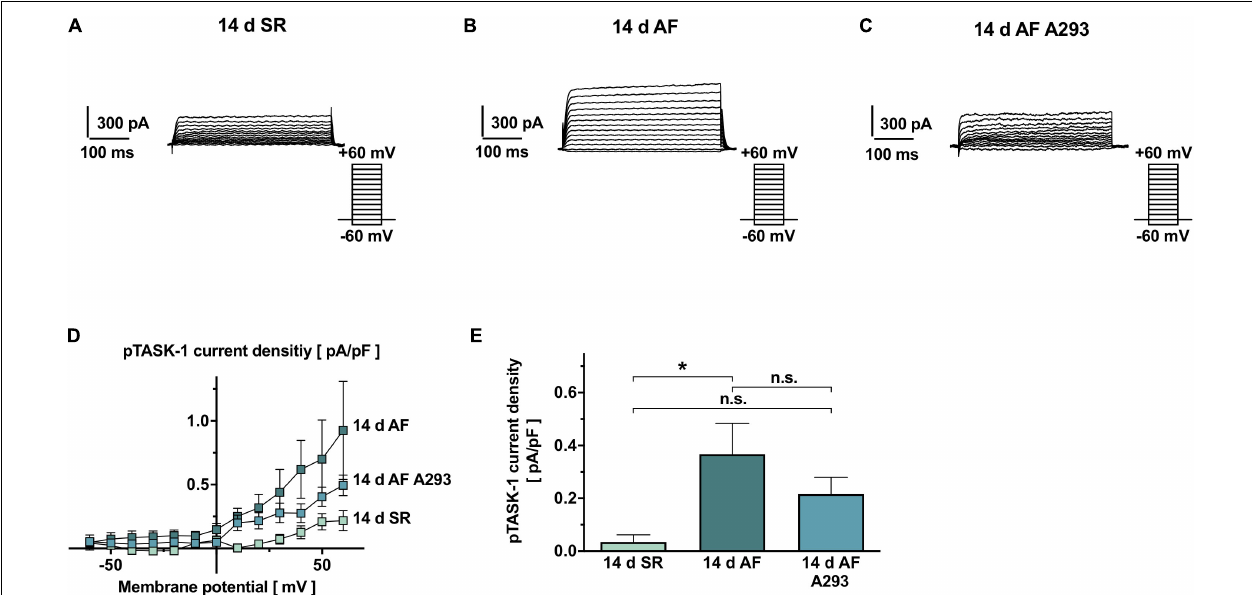
FIGURE 3 | Patch clamp recordings of atrial TASK-1 currents from SR and AF pigs, as well as AF pigs during A293 treatment. (A–C) Representative TASK-1 current recordings, performed in atrial cardiomyocytes isolated from atrial fibrillation (AF) or SR pigs at the end of the 14 days treatment period. TASK-1 currents were calculated as differences to background currents after administration of 200 nM A293. (D) Current-voltage relationships of isolated TASK-1 current densities for the treatment and control groups ( n = 10–15 cells, from 4 different animals per group). (E) Comparison of average A293-sensitive current densities among the study groups, quantified at the end of a +20 mV pulse (insert: pulse protocols and scale bars; dotted lines, zero current levels; error bars, SEM; * P < 0.05 from Student’s t